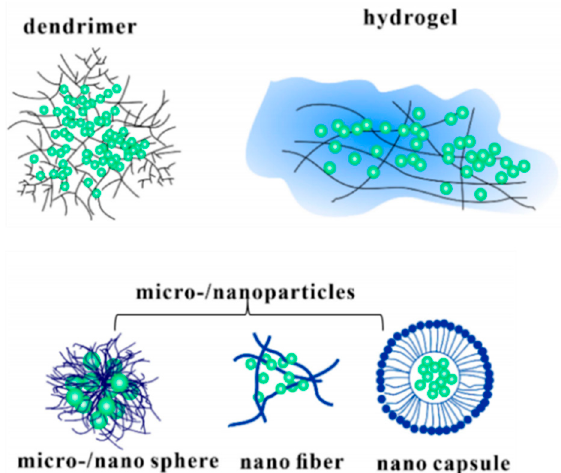
Figure 1. Drug release from implantable biomaterials and description of various types of carrier-based drug-releasing biomaterials [64].